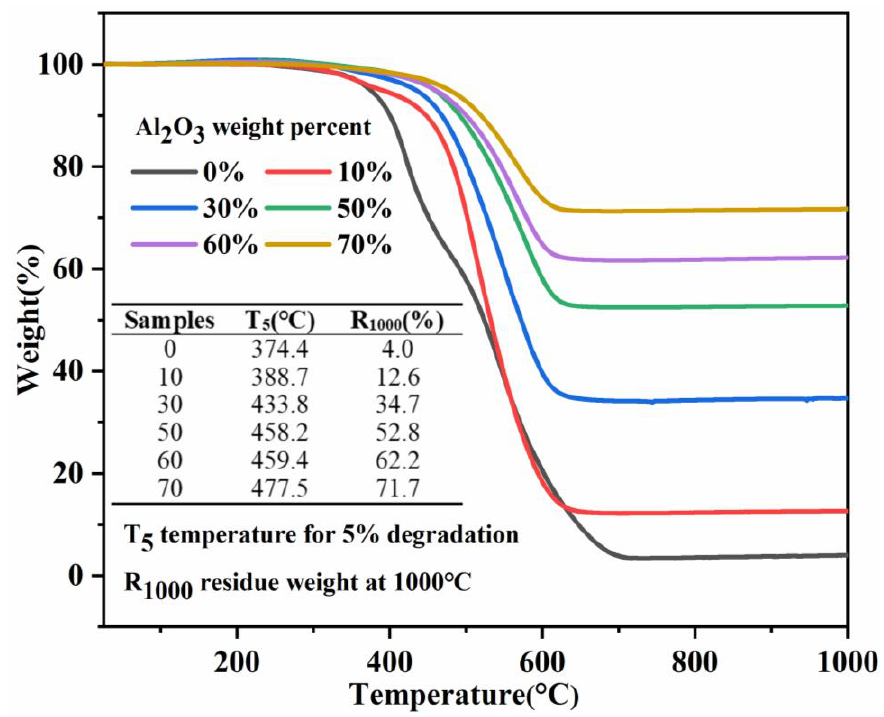
Figure 5. The weight loss curves of B-Al 2 O 3 /SR